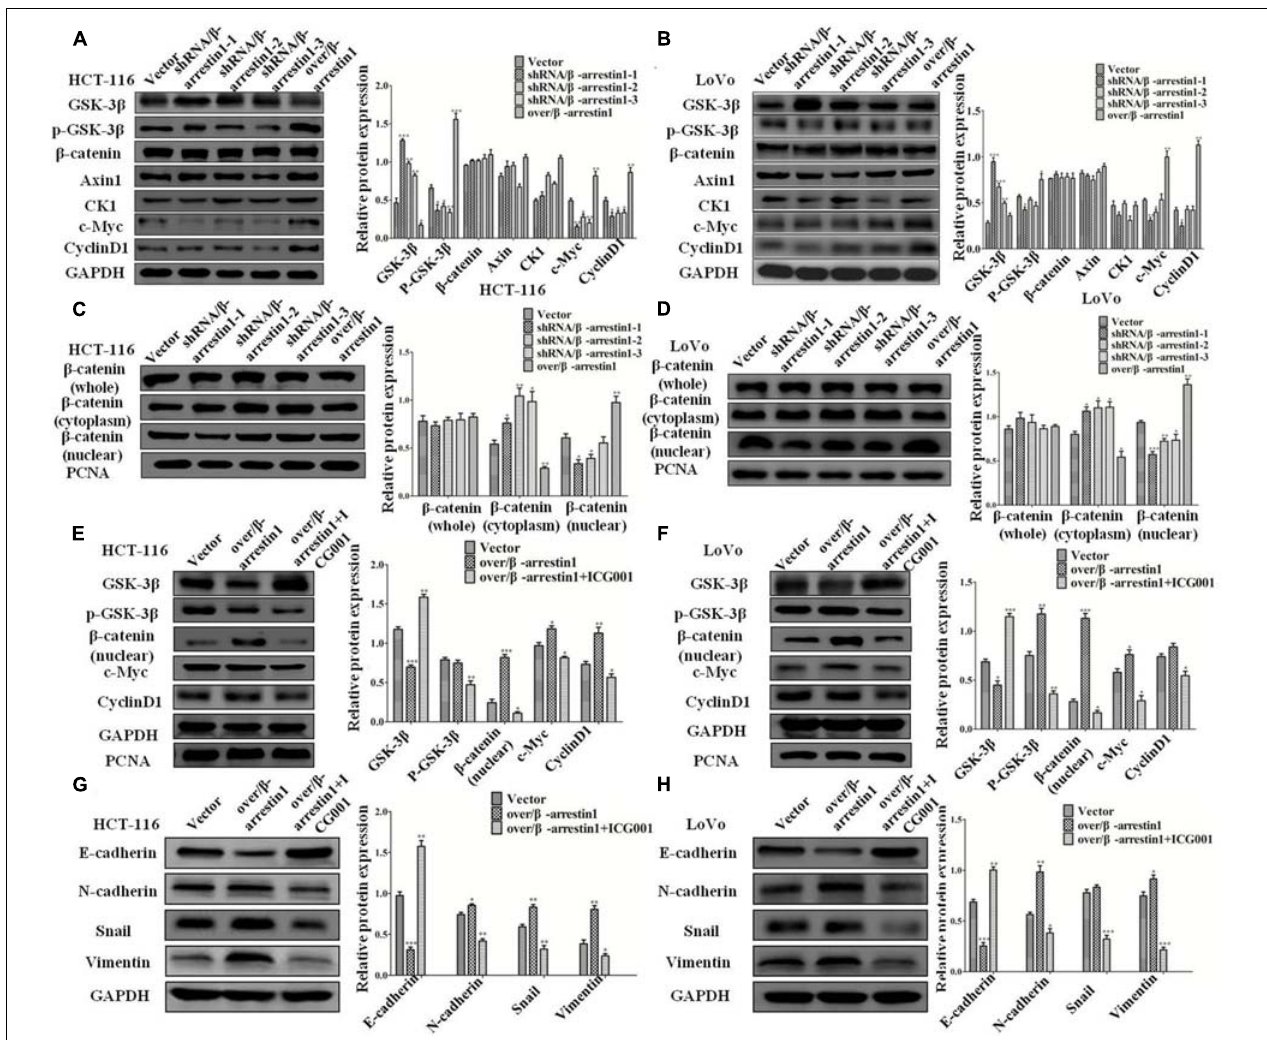
FIGURE 6 | β -arrestin1 regulates the Wnt/ β -catenin signal pathway in CRC cells. (A,B) Western blotting detected the protein levels of GSK-3 β , p-GSK-3 β , Axin1, CK1, β -catenin, c-Myc and CyclinD1 in shRNA/ β -arrestin1 and over/ β -arrestin1 groups. * P < 0.05; ** P < 0.01; *** P < 0.001 vs. HCT-116-vector or LoVo-vector cells. (C,D) The protein expression of β -catenin in whole or cell extracts of different cellular compartments from HCT-116 or LoVo cells. * P < 0.05; ** P < 0.01; *** P < 0.001 vs. HCT-116-vector or LoVo-vector cells. (E,F) β -catenin inhibitor ICG001 (10 µ M) was added to the over/ β -arrestin1 group, and then cultured for 24 h. The associated proteins of the Wnt signaling pathway were examined via western blotting. * P < 0.05; ** P < 0.01 vs. HCT-116-vector or LoVo-vector cells. (G,H) Western blotting detected the protein expression levels of epithelial or mesenchymal markers after using ICG001. * P < 0.05; ** P < 0.01; *** P < 0.001 vs. HCT-116-vector or LoVo-vector cells. CRC, colorectal